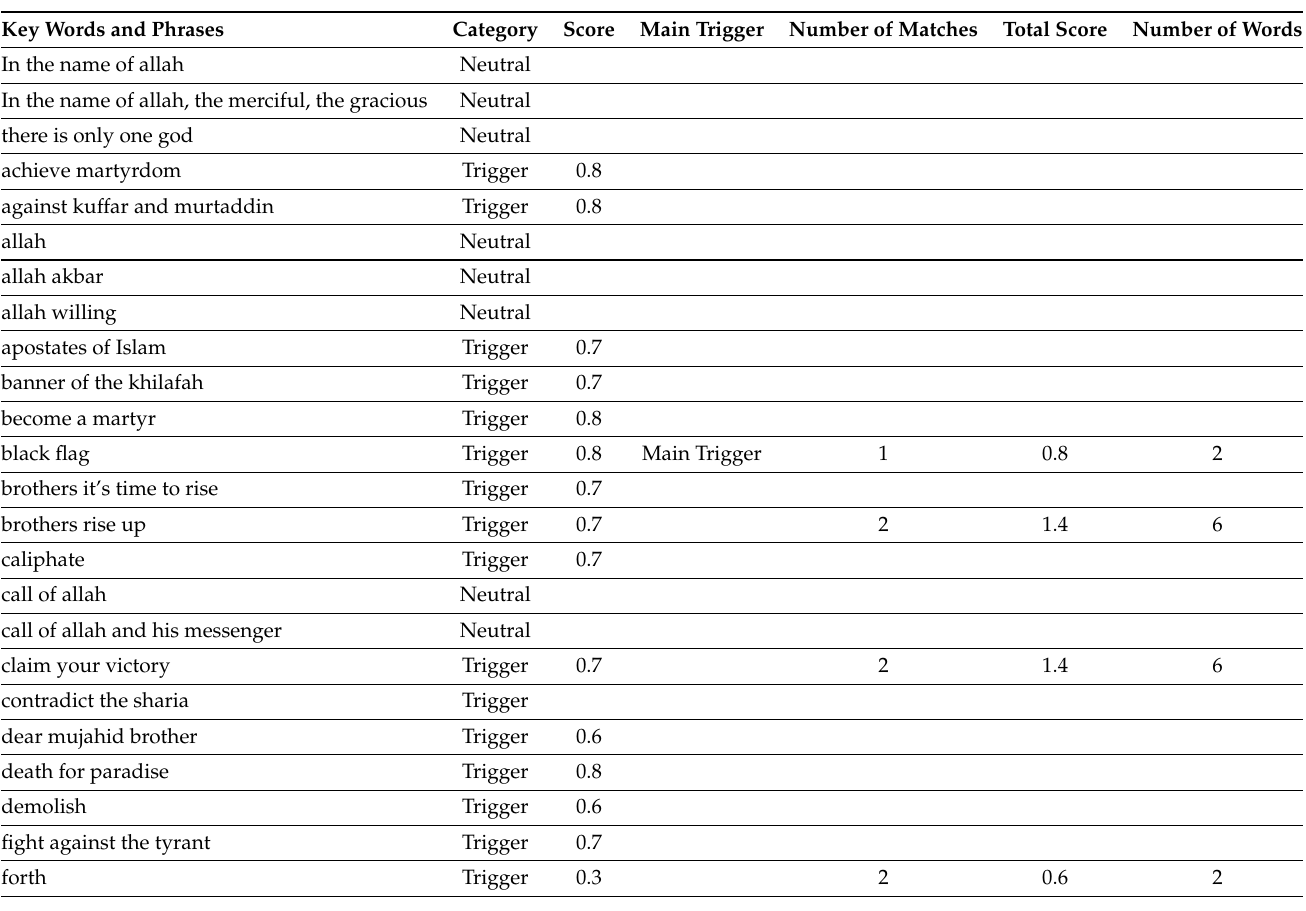
Table 2. Extract of the scoring list of text analysis.